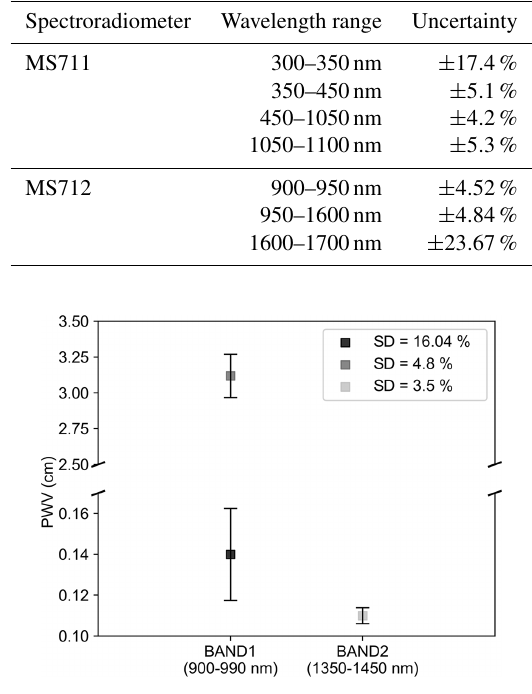
Figure 8. Mean and error bars of the PWV retrievals obtained using BAND1 and BAND2 based on the method described in Sect. 3.2 for the spectral curves after overlaying the calibration